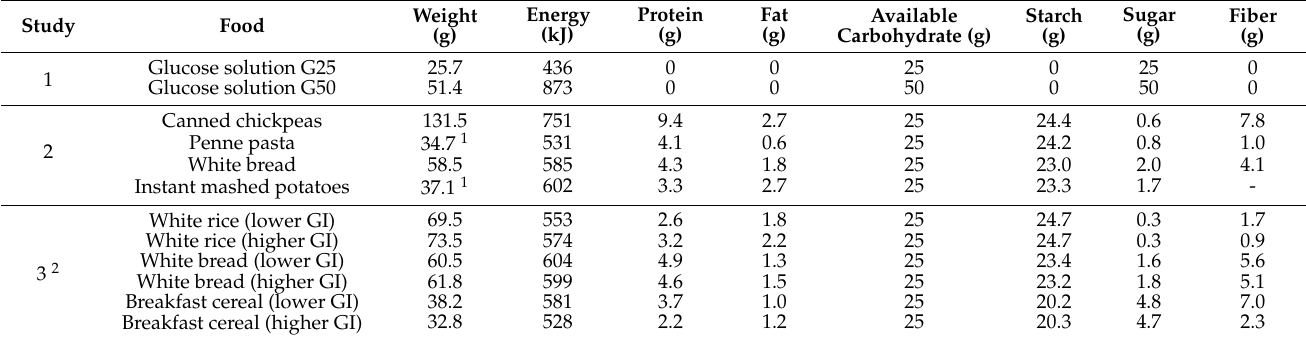
Table 1. Nutritional information for the foods tested in each